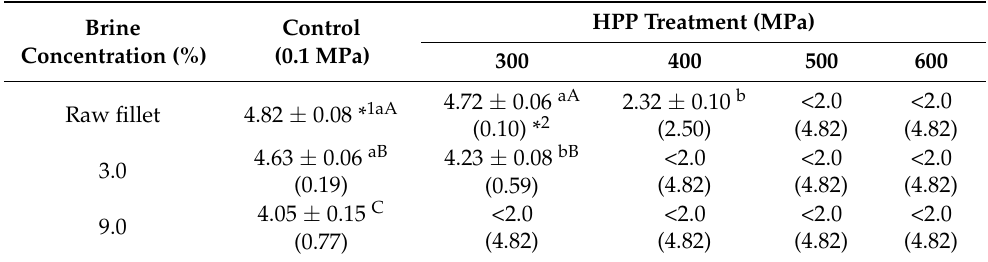
Table 1. The aerobic plate count (log CFU/g) of mackerel fillets after the brine salting of 3.0% and 9.0% for 90 min at 4 ◦ C and then pressurization at 300, 400, 500, and 600 MPa for 5 min.